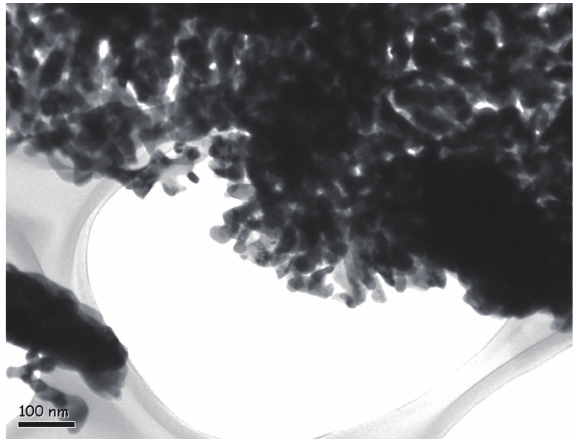
F 6: Fourier transform infrared (FTIR) spectroscopy of mixed Cu-Mn oxide (Cu:Mn=1:2) precalcined at 300 mixed oxide. Peaks appearing in the range 1223–1713 cm